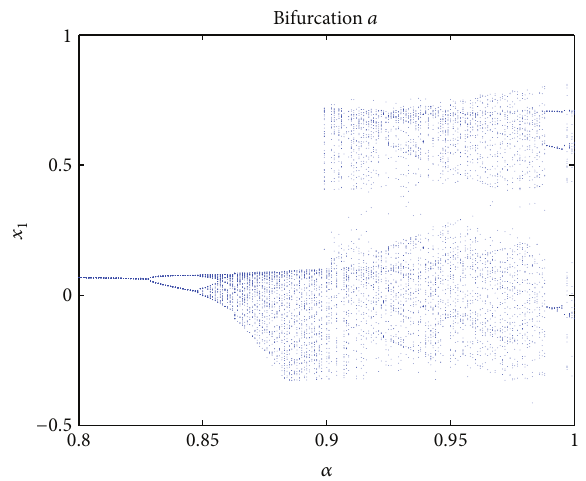
Figure 3: Bifurcation diagrams of 𝑥 1 with respect to the derivative order 𝛼 when 𝑏 22 = 2.0, 𝑐 22 = −1.5